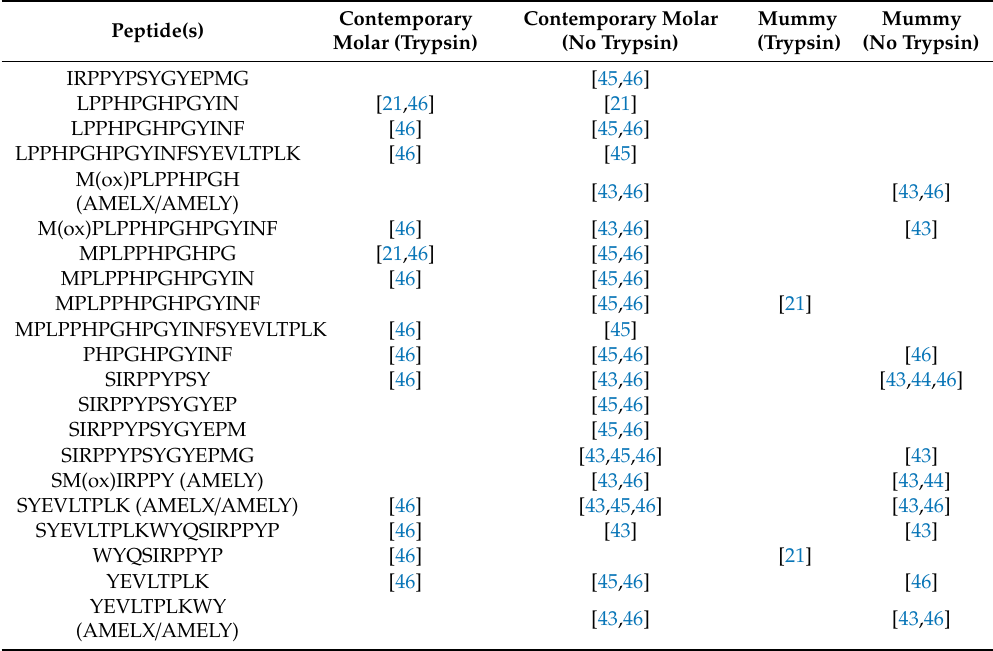
Table 1. Peptide sequences identified from amelogenin. Only peptides identified in a minimum of 2 samples are illustrated in this table. Peptides from isoform Y are annotated. Porto et al. [21]; Lugli et al. [43]; Stewart et al. [44]; Castiblanco et al. [45]; Stewart et al.